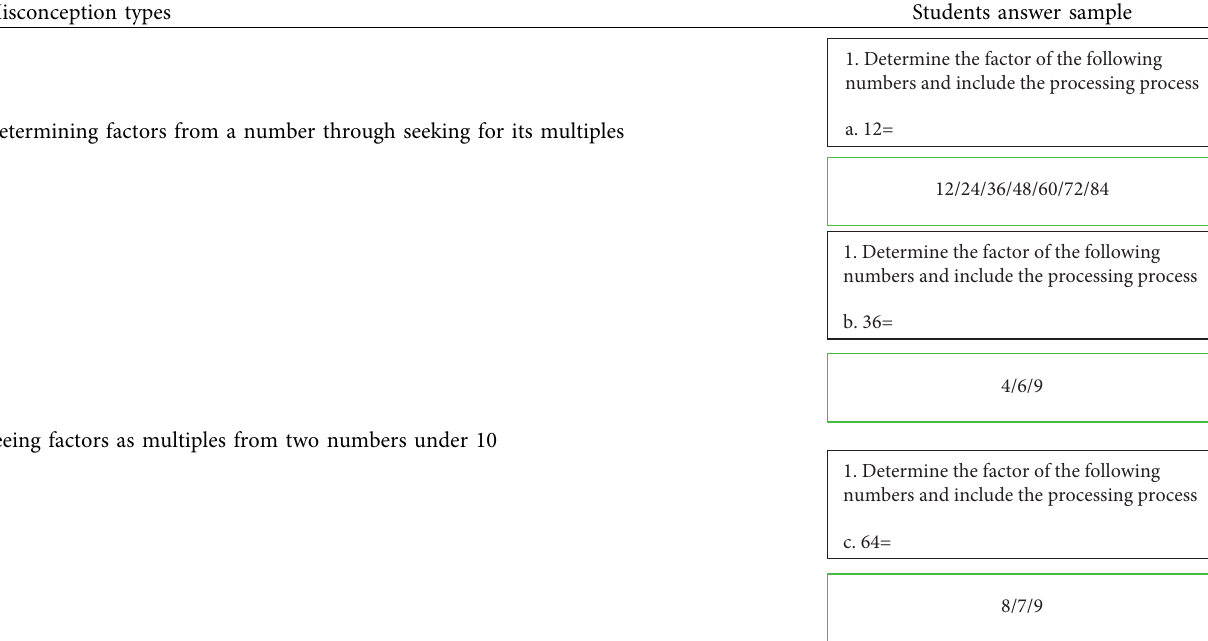
Table 3: Students’ misconception in question 1 and examples of students’